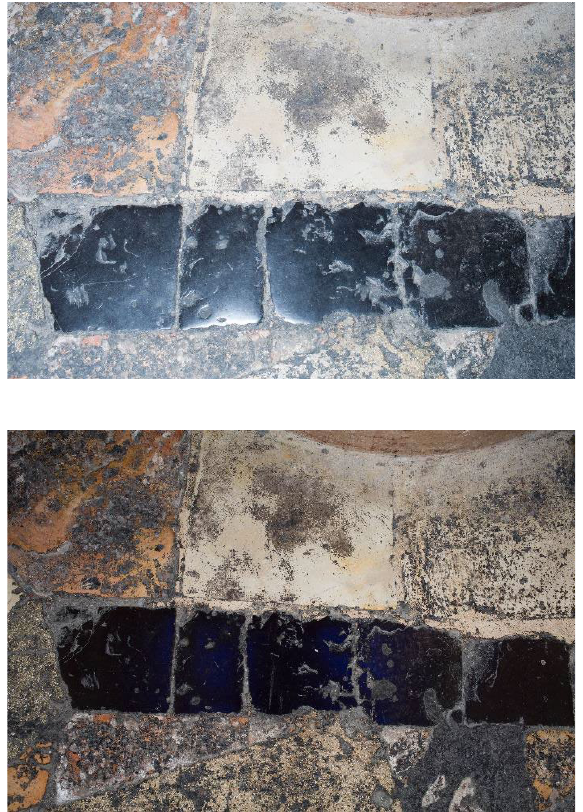
Figure 5 : comparison between images acquired without (top) and with (bottom) the acquisition system. The differences are evident especially on the black marble where all the reflections are deleted and the stones appear